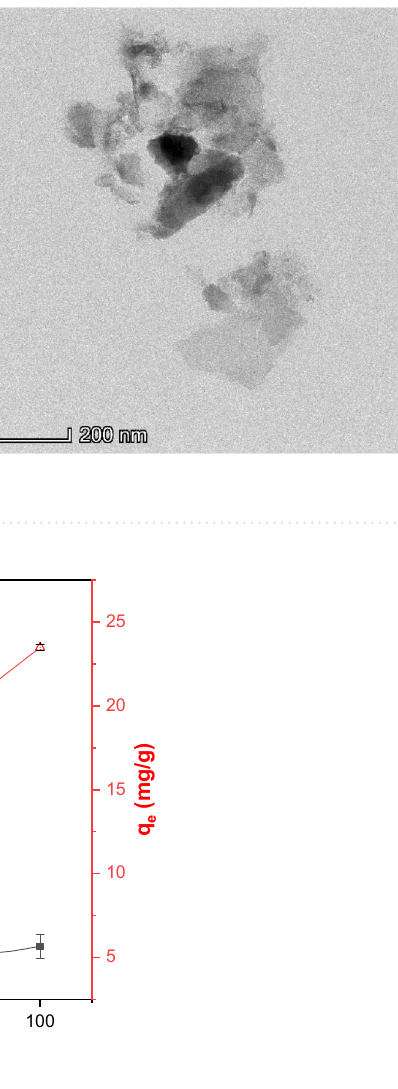
Figure 7. Effect of initial concentration on adsorptive CR removal using GSC WCO